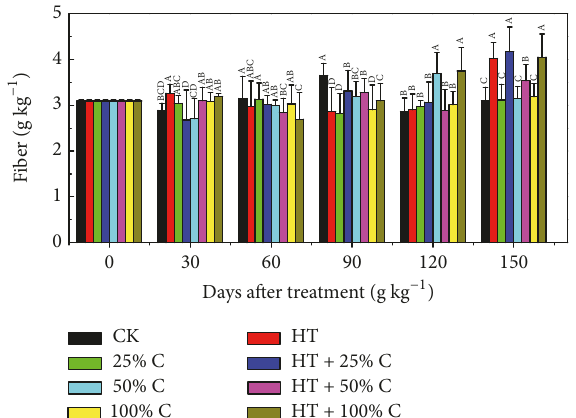
Figure 5: Effects of combined heat and preservative treatments on total fiber content in the fruit peel during storage. “C” represents the concentration of preservative used in production. The error bars represent the standard errors. Different superscripts between columns represent significant differences between samples at the 0.05